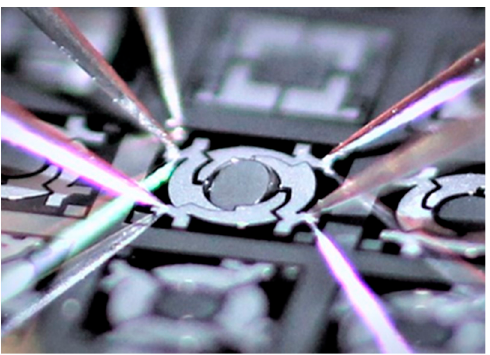
Figure 21. Photograph of a micromirror at wafer level of Design 2 in operation at 50 V (approx. 30° mechanical tilt angle) captured by a single lens reflex (SLR) camera (Canon EOS 600D).